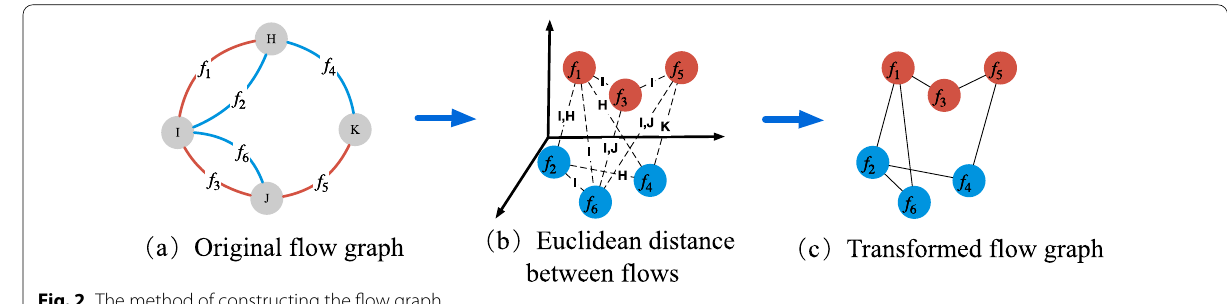
Fig. 2 The method of constructing the flow